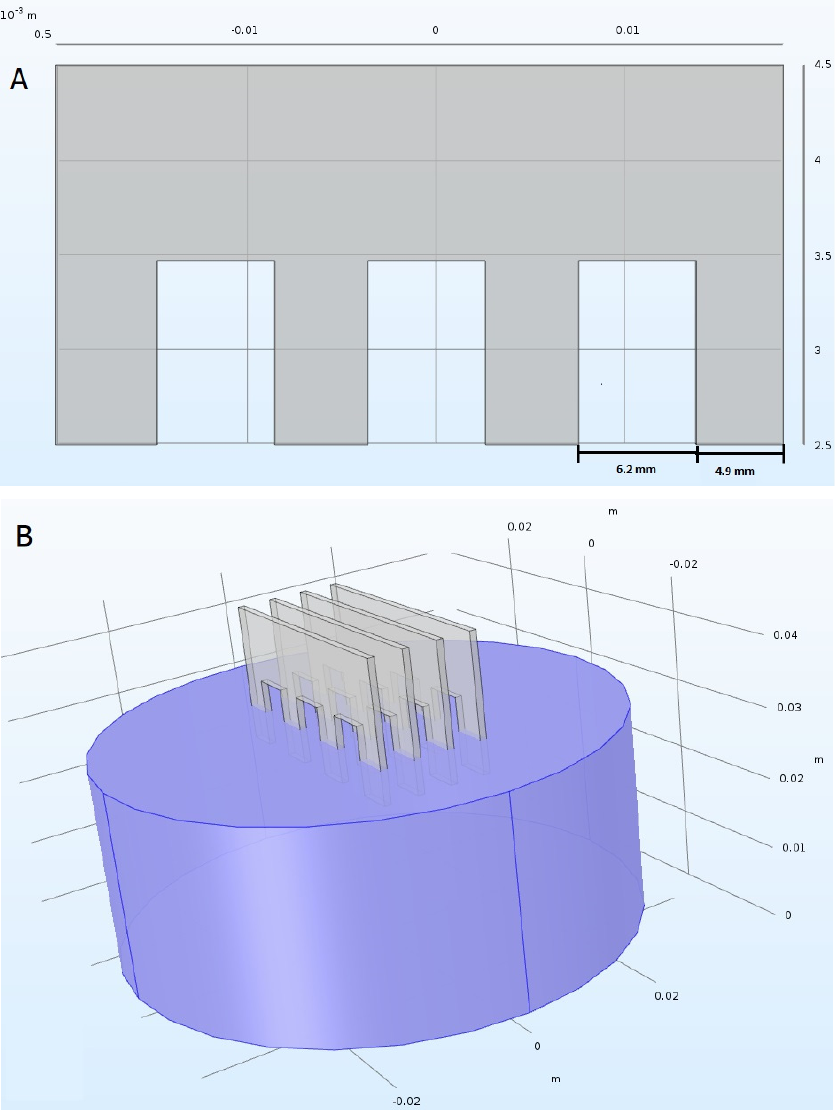
Figure 10. Schematic representation of a single electrode ( A ) and set of electrodes immersed into the culture medium ( B ). culture medium ( B